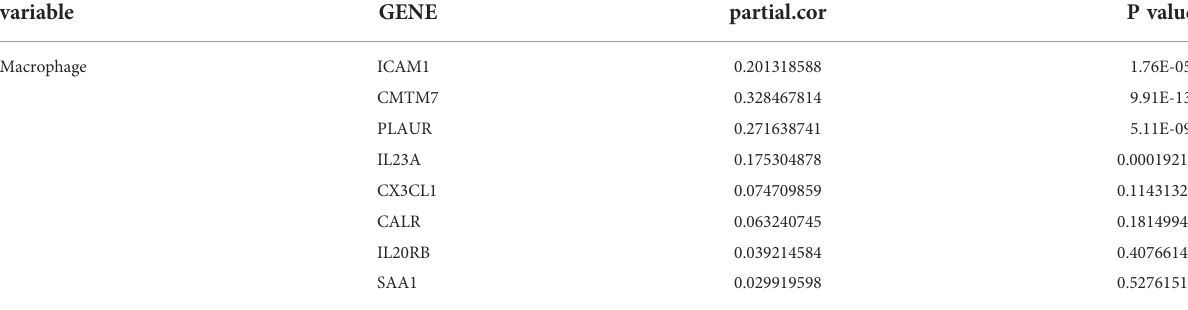
TABLE 1 Gene expression positively correlates with the in fi ltration level of macrophages in KIRC tissues.